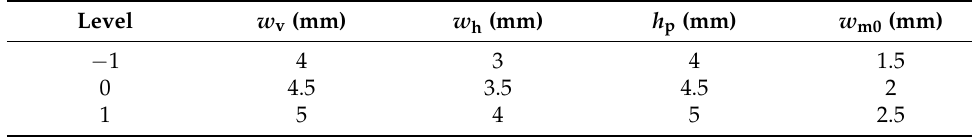
Table 5. Design variable level value.